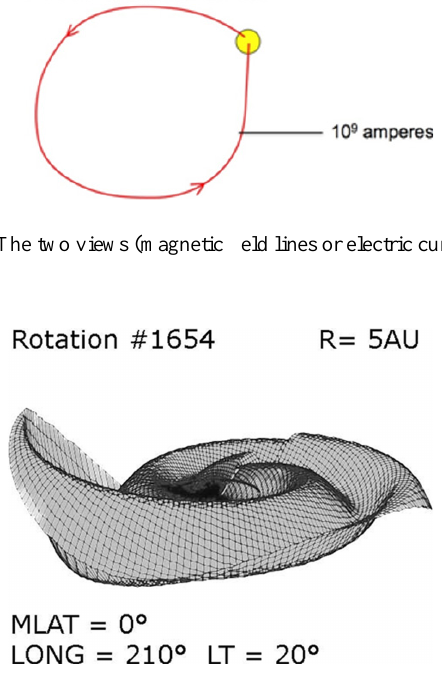
Fig. 25. The warped current sheet to a distance of 5au (Akasofu and Fry, 1986).